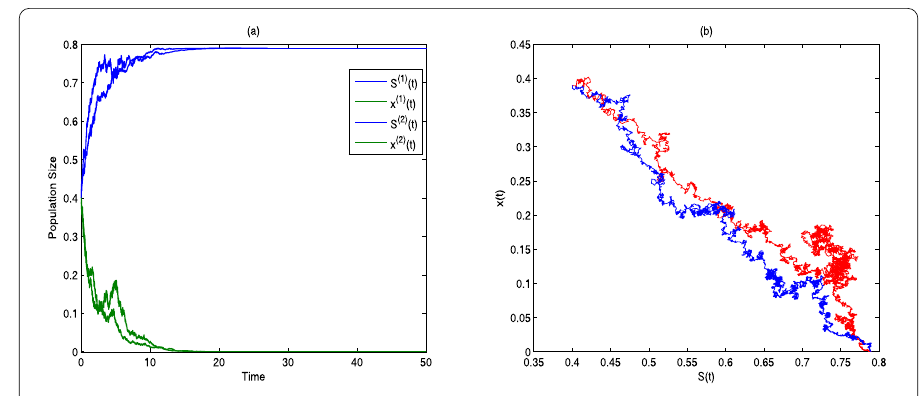
Figure 6 The time series and portrait phase of model (4.3) when α = 0.87 ( S (1) ( t ) and S (2) ( t ) are two sample paths about S ( t ), x (1) ( t ) and x (2) ( t ) are two sample paths about x ( t ).) ( a ) stands for the time series of S ( t ) and x ( t ); ( b ) stands for the portrait